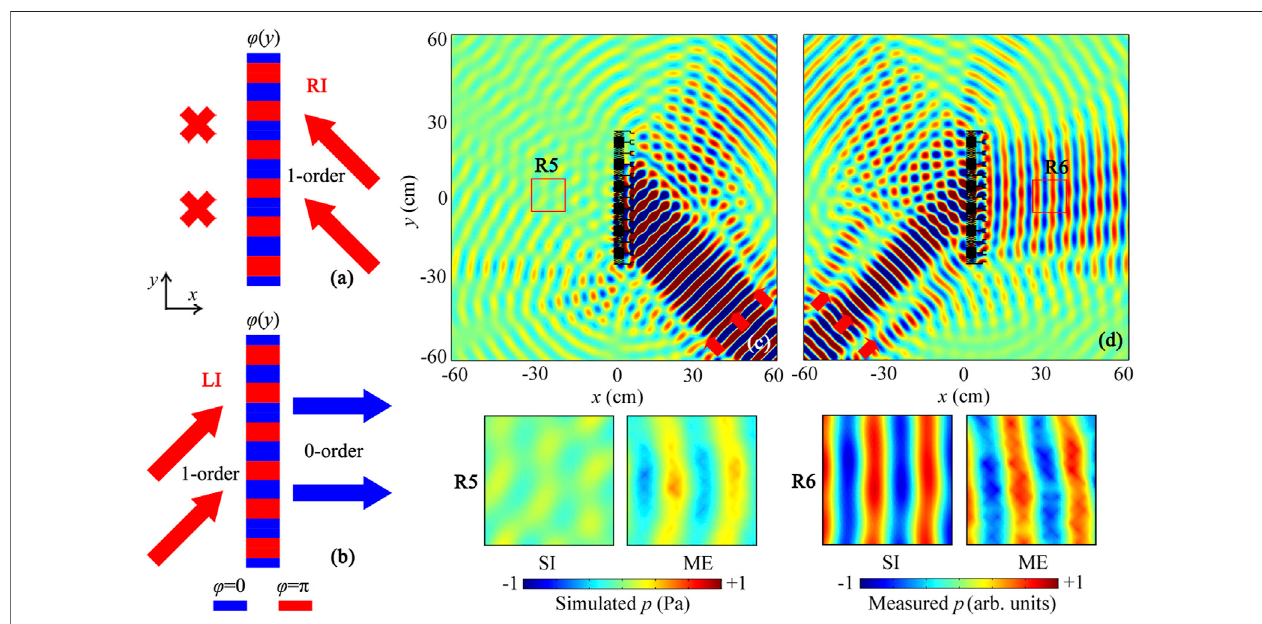
FIGURE 7| Schematic of propagation paths through the UAI lens under the incidence ofthe fi rst-order wave for (A) RI and (B) LI. Simulated pressure distributions created by the UAI lens under the incidence of the fi rst-order wave for (D) RI and (E) LI at 7.1 kHz. Red solid arrows in (A – D) are the fi rst-order wave. Four insets on the bottom are the simulated and measured intensity distributions in red open squares R5 and